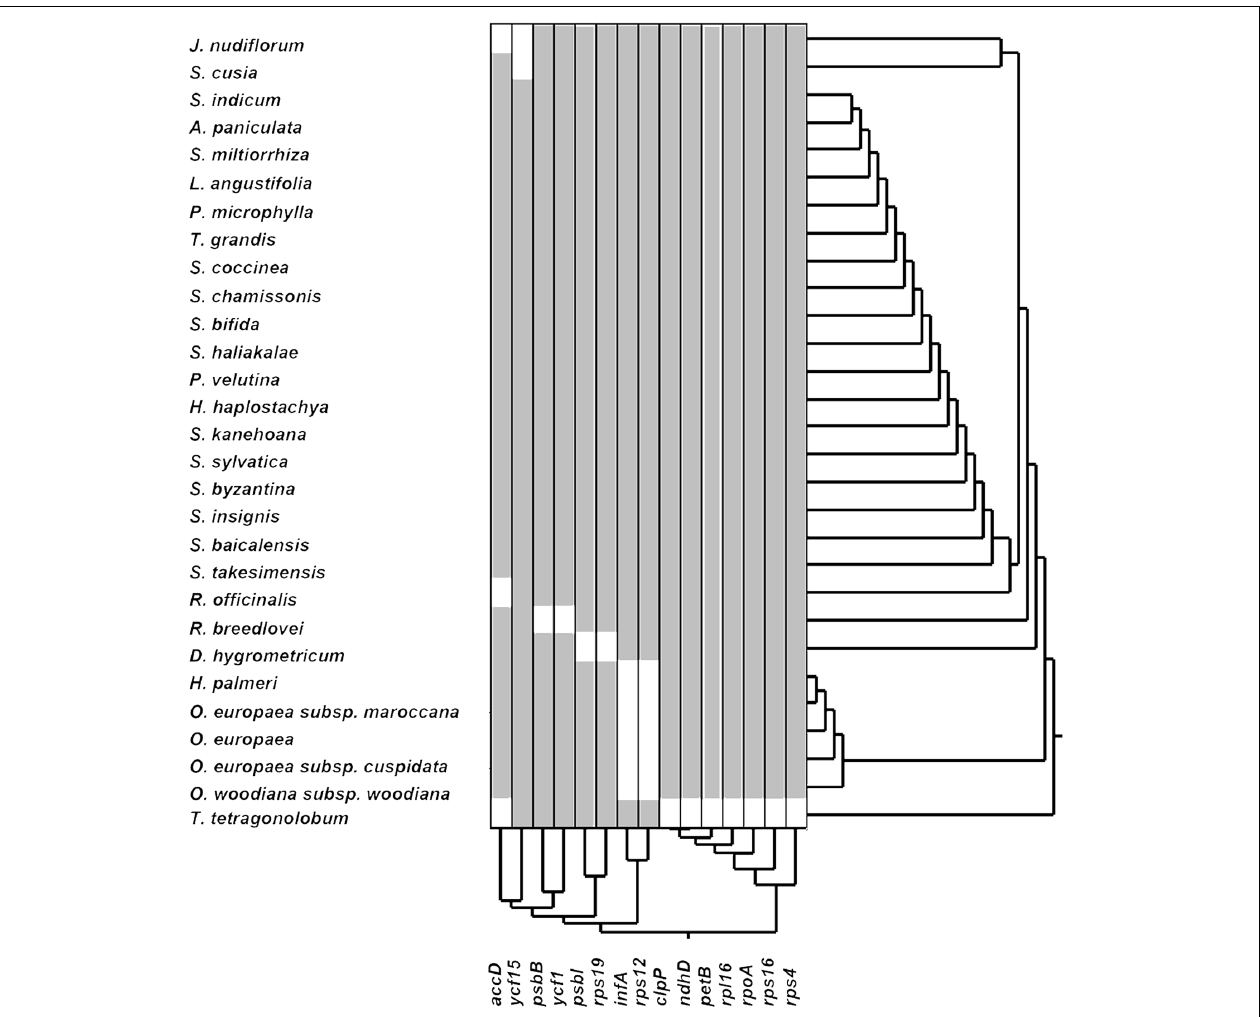
FIGURE 2 | Gene losses in the cp genomes of the Lamiales